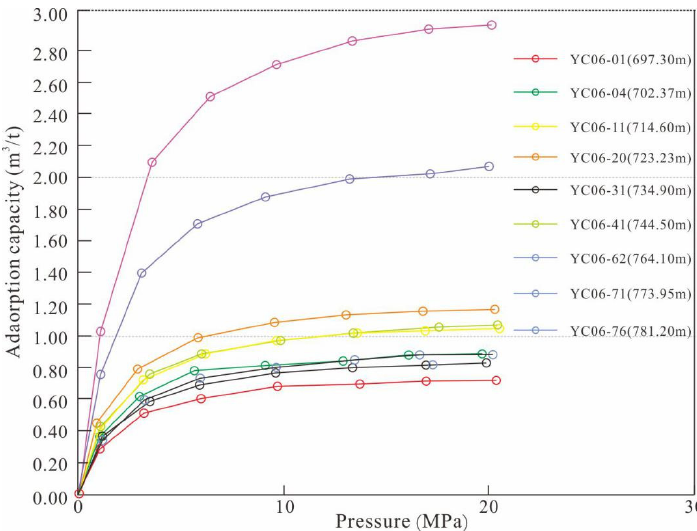
Figure 6. Methane isothermal adsorption curve of shale samples from Well Yucan-6.